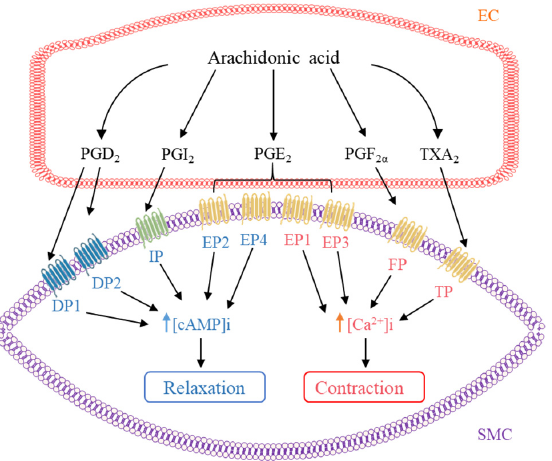
Figure 3. Regulation of vascular tone by arachidonic acid metabolites. Arachidonic acid metabolites produced in endothelial cell (EC) including prostaglandin (PG)D 2 , PGE 2 , PGF 2 α , prostacyclin (PGI 2 ), and thromboxanes (TX)A 2 target to their corresponding receptor in smooth muscle cell (SMC), increasing intracellular cAMP level [cAMP]i to induce relaxation or decreasing intracellular calcium level [Ca 2+ ]i to induce contraction.